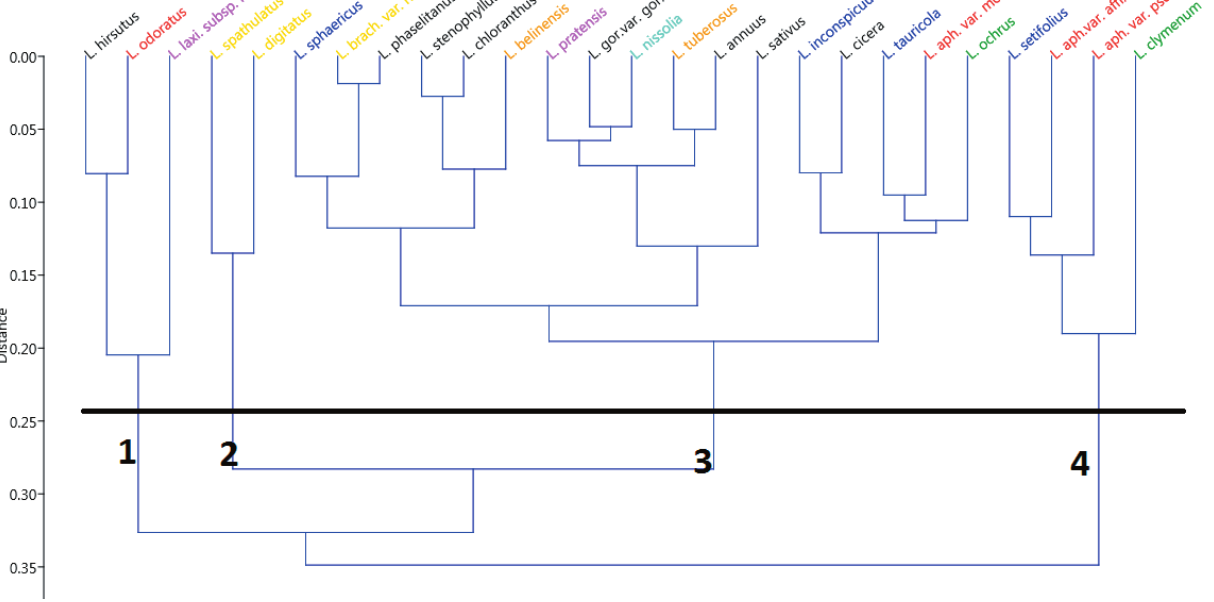
Figure 6. Cluster analysis according to karyotype characteristics (Same coloured taxa are located in the same section except L. odoratus . It is an ornamental plant).